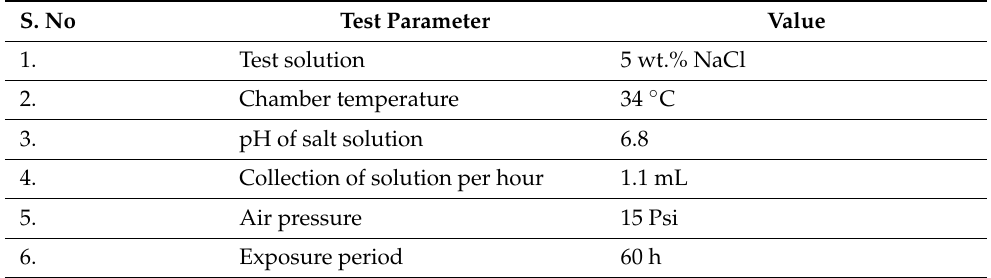
Table 3. Salt spraying test parameters and